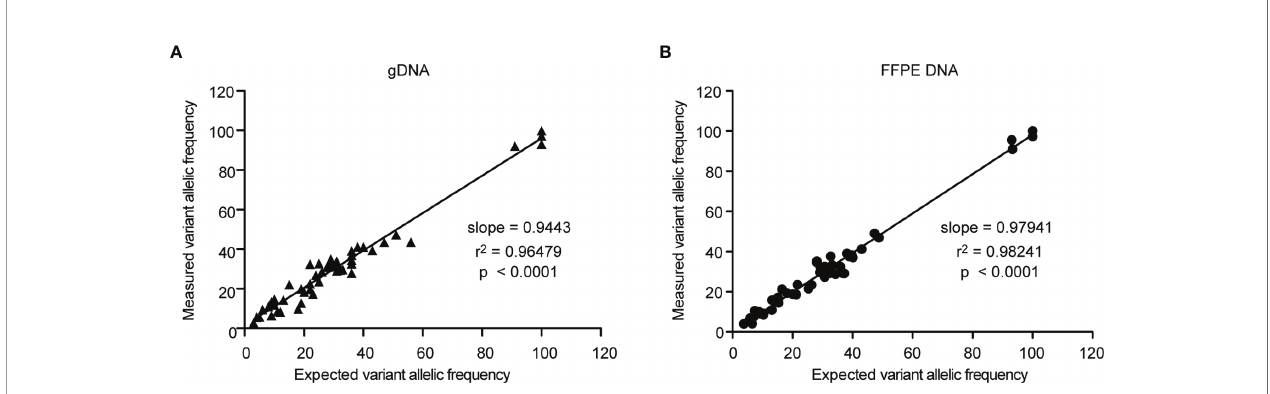
FIGURE 1 | Linear regression analysis of the expected allele frequencies versus measured allele frequencies employing the Glio-DNA panel. Correlation between expected and measured variant allele frequencies (expressed as percentage) evaluated by regression analysis for genomic (left panel) and FFPE (right panel) standard DNA using the Glio-DNA